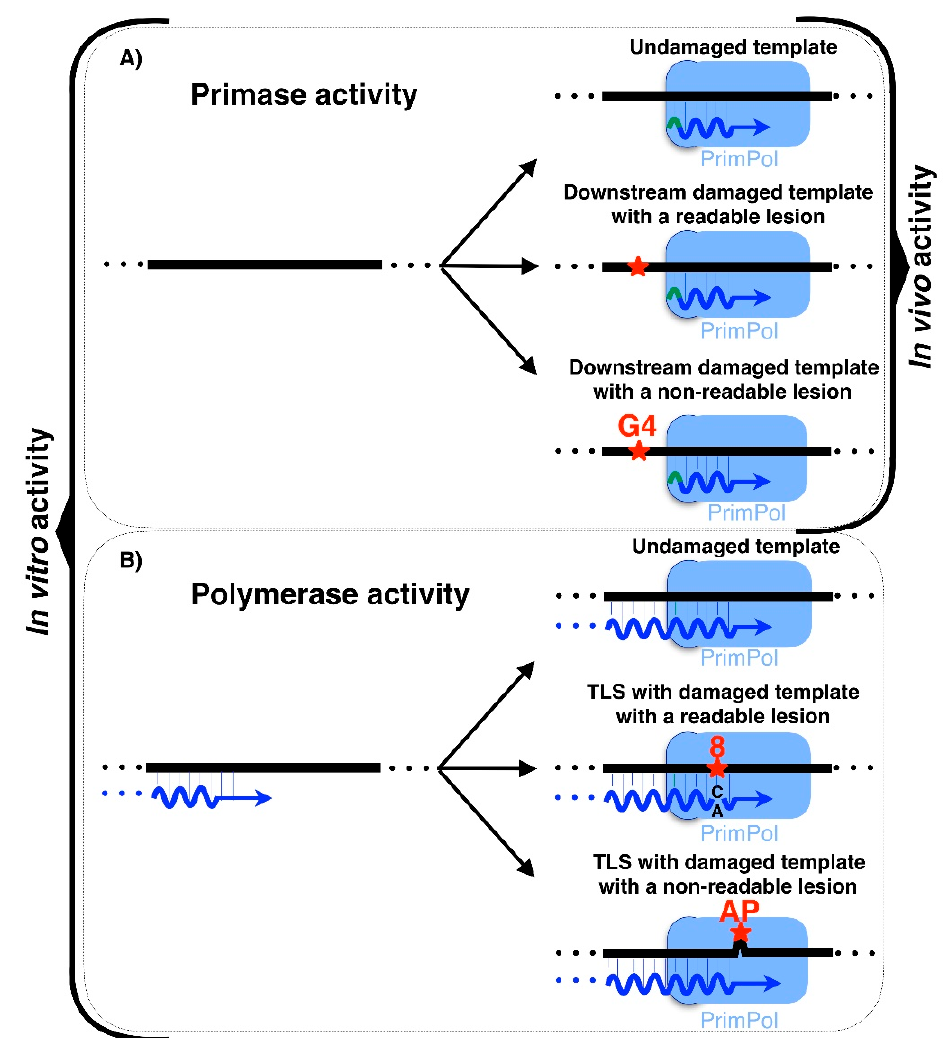
Figure 3. “In vitro and in vivo activities of the human PrimPol. ( A ) Primase activity of PrimPol. ( B ) Polymerase activity of PrimPol. Both panels are broken down into polymerization with undamaged templates or damaged templates with both readable and non-readable lesions. Only the primase activity of PrimPol was shown both in vitro and in vivo. Polymerase activities are shown only in vitro and their relevance in vivo remains unclear. dNMPs are colored in blue, NTPs in green and DNA lesions in red. G-quadruplex are depicted as G4 in red, the 8oxodG lesion is depicted as an 8 colored in red (readable lesion), and the abasic site is depicted as AP colored in red (non-readable lesion). Asterisks indicate lesions.”. Table 1. It was modified to reflect only critical residues for PrimPol function that have been described in peer-reviewed research articles. The corresponding references are included in the table. The legend of Table 1 was modified